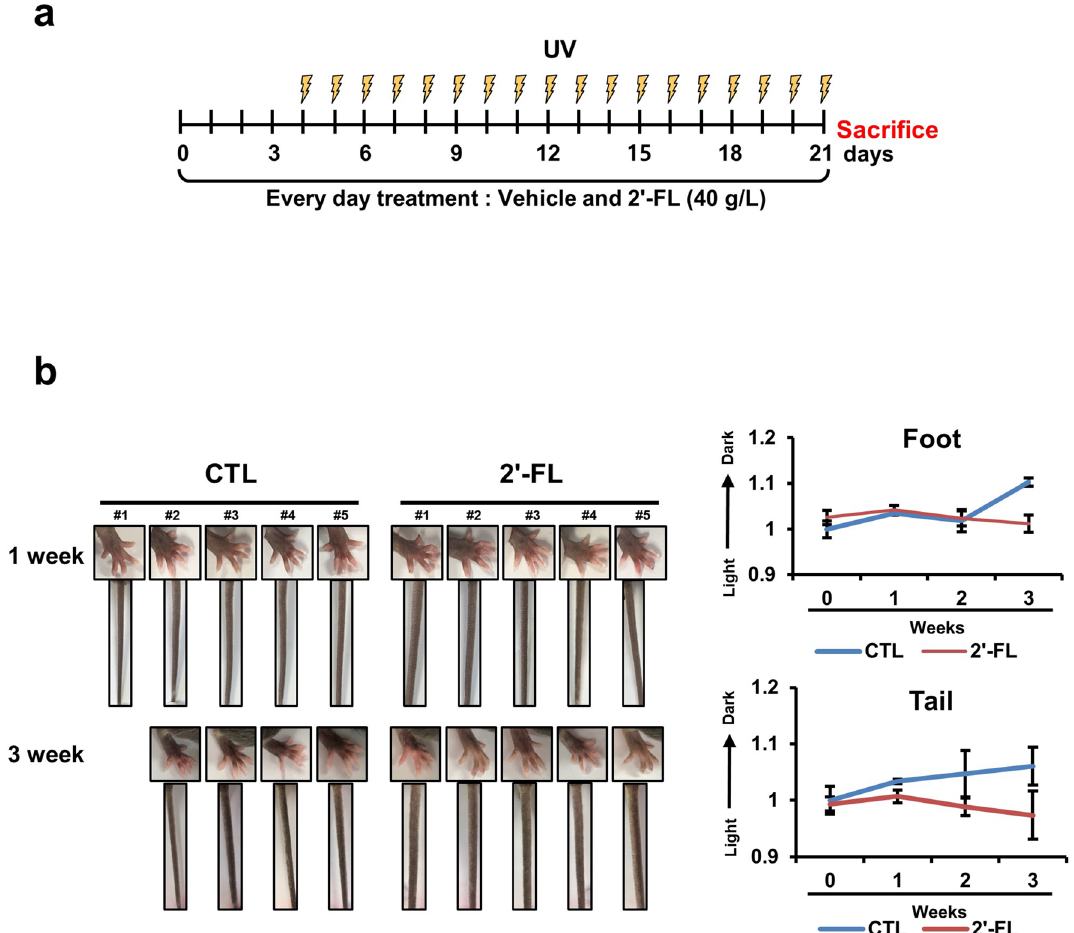
Figure 5. 2’-Fucosyllactose reduces melanin production in a mice model. ( a ) Schedule of the in vivo experiment. ( b ) Feet and tail pigmentation differences between control (n = 4) and 2’-FL-treated groups were measured by color analysis. L-values before treatment were used as reference. Low and high relative L-value indicate darkness and whiteness,